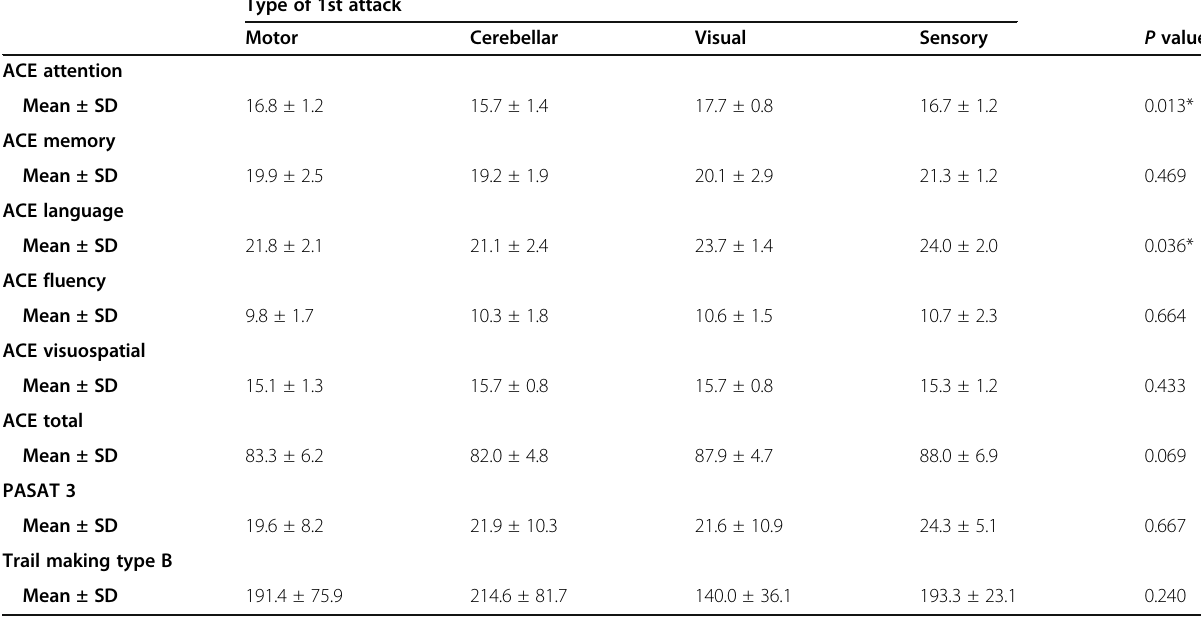
Table 5 Comparison of mean scores of cognitive scales between MS patients with different types of first attack